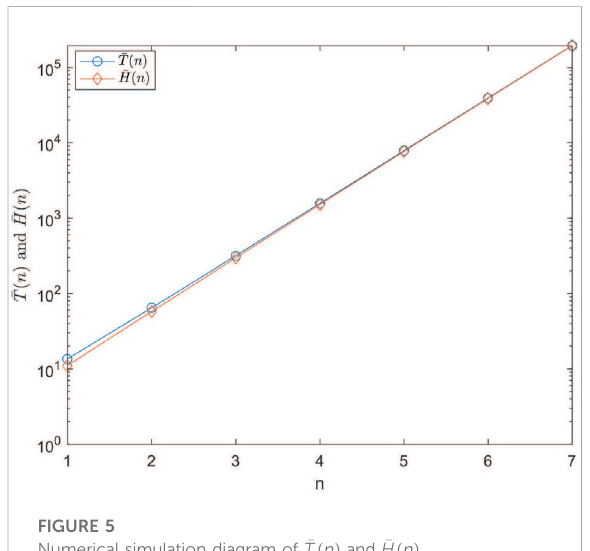
FIGURE 5 Numerical simulation diagram of (cid:1) T ( n ) and (cid:1) H ( n )